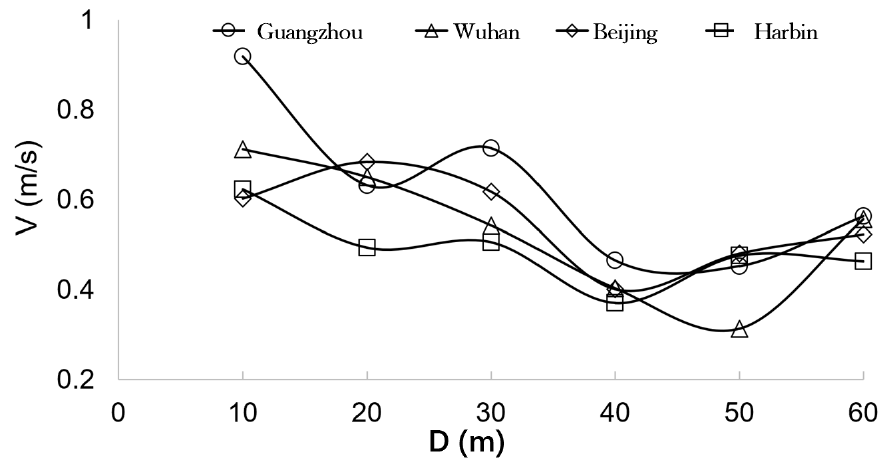
Figure 9. The relationship between building distance and average V in the four cities.